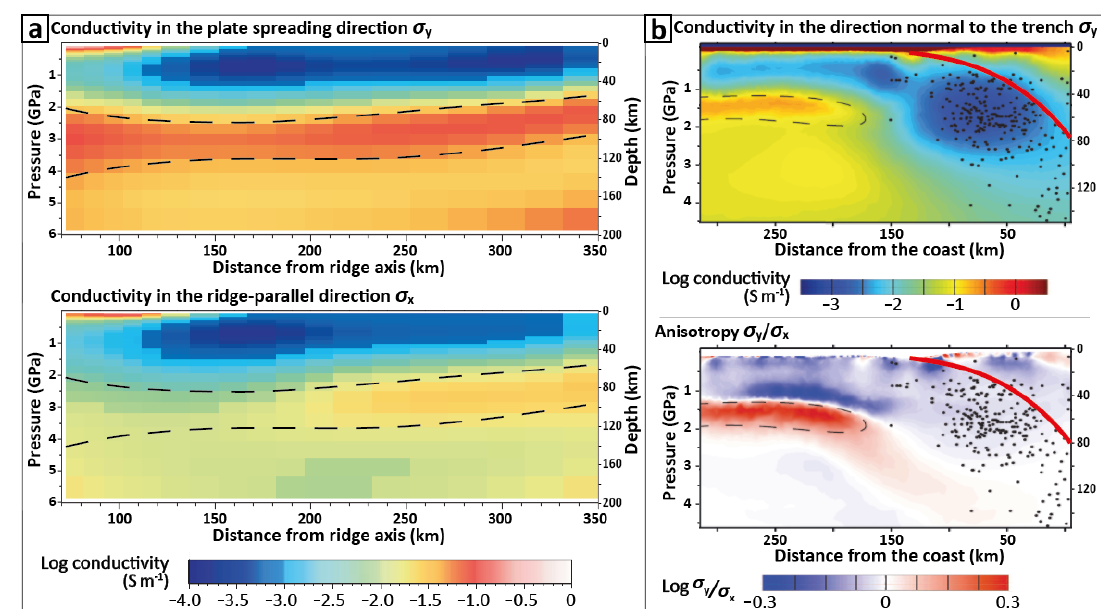
Figure 1. High-conductivity channels at the bottom of the Nazca and Cocos Plates. Comparison between two MT profiles showing anisotropic high-conductivity features below the Nazca Plate (( a ) east of the EPR, 3–6 Ma) [1] and within the Cocos Plate (( b ) offshore Nicaragua; 22–25 Ma) [3]. For the young Nazca Plate ( a ), the conductivity reaches only ∼ 8 × 10 − 2 S · m − 1 in the spreading direction ( σ y ) and σ y / σ x reaches ≈ 10; for the old portion of the Cocos Plate ( b ), the conductivity reaches up to ∼ 2 × 10 − 1 S · m − 1 in the direction normal to the trench ( σ y ) and σ y / σ x ≈ 2. The dashed black lines locate the anomaly and highlight its anisotropic nature. The thick red line ( b ) corresponds to the subduction interface.